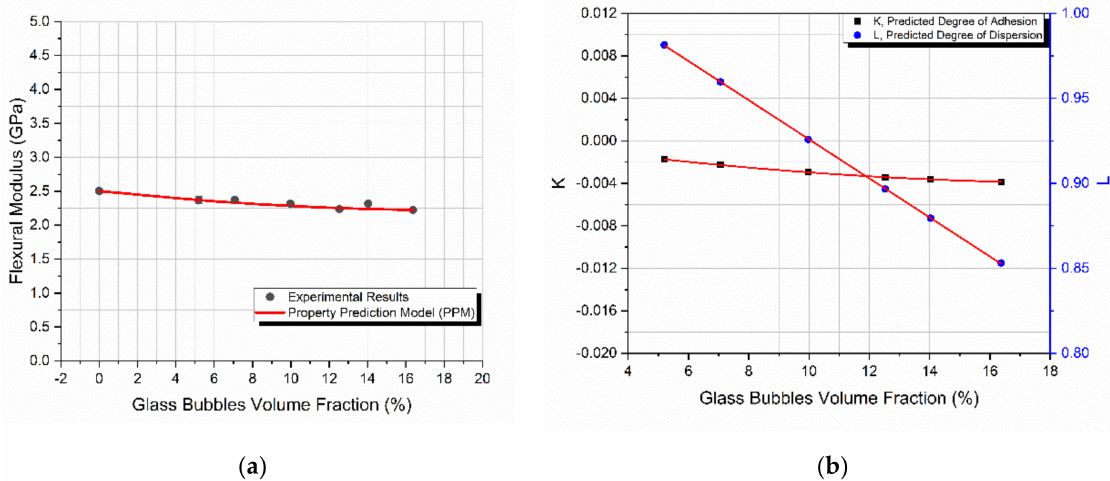
Figure 5. The starch-epoxy composites variation of glass bubbles with the filler-volume fraction V f , of ( a ) flexural modulus experimental and predicted values, ( b ) degree of adhesion K , and degree of dispersion L predicted values.